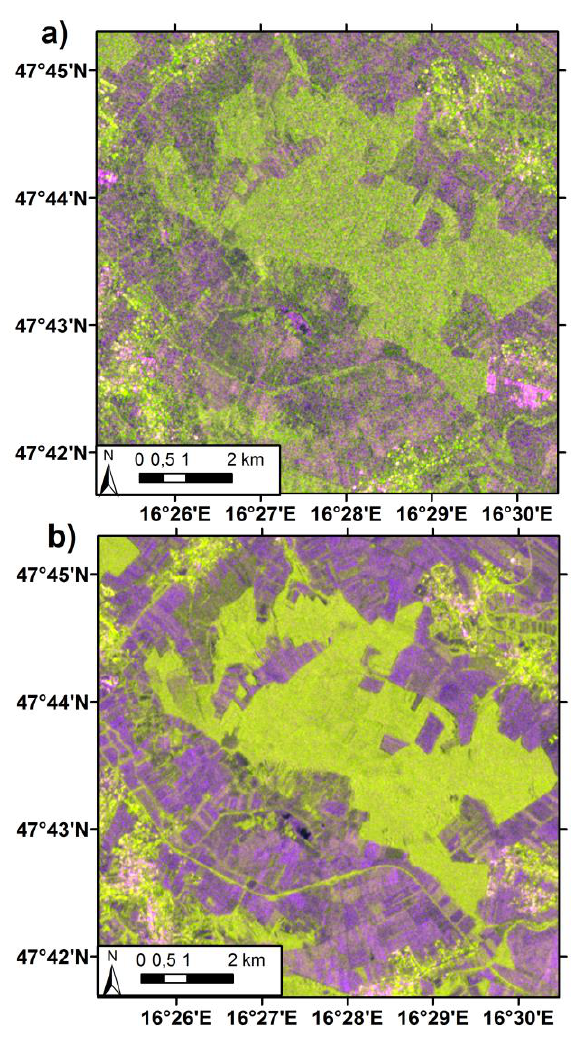
Figure 3: 10 by 10 km training area: a) RGB composite of VV polarization backscatter in red band, VH polarization backscatter in green band and their difference in blue band from 25 th December 2014, b) RGB composite (VV, VH and their difference) of the dry parameter over the winter period